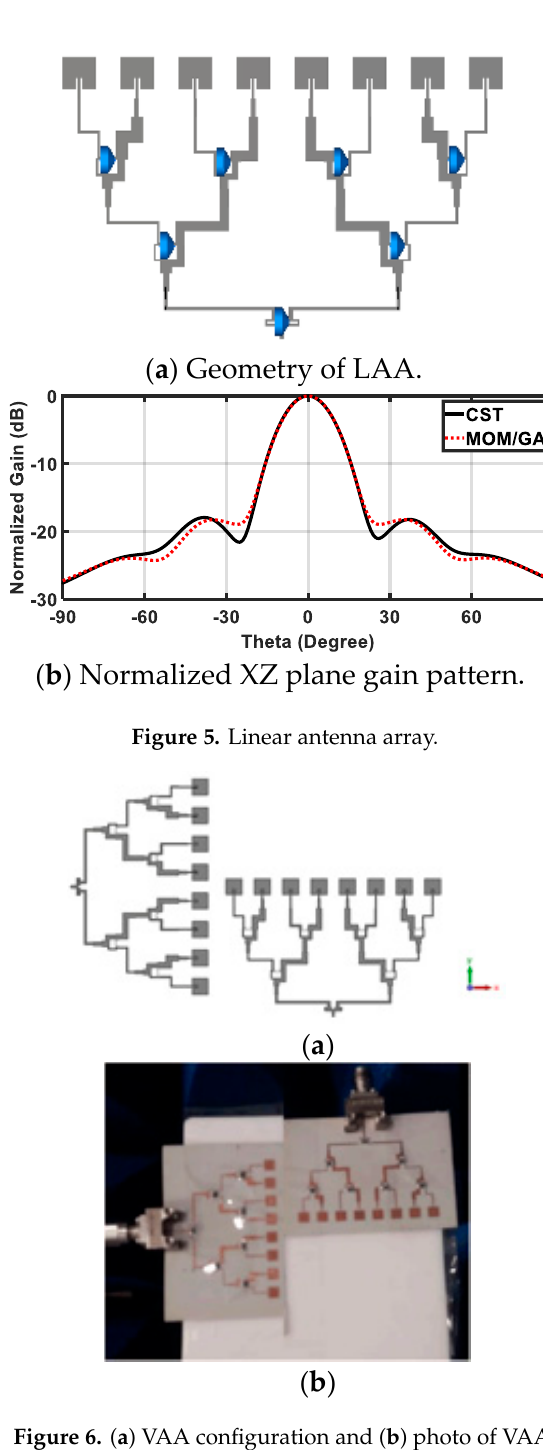
Figure 6. ( a ) VAA configuration and ( b ) photo of VAA.